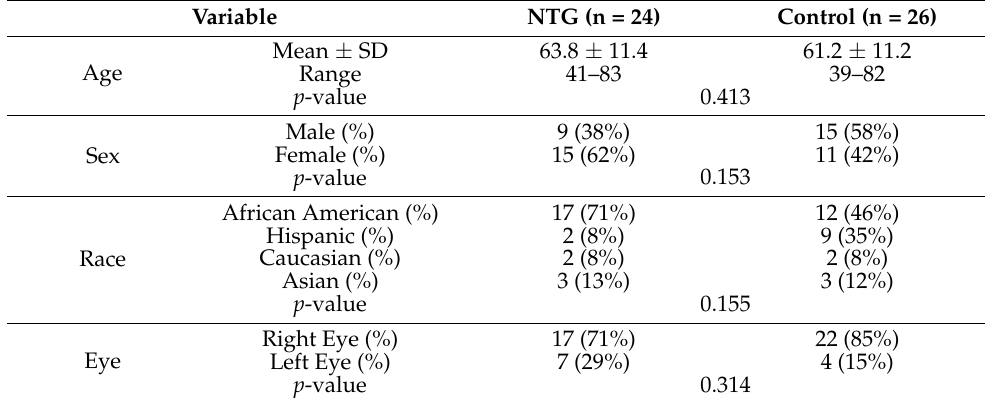
Table 1. Demographic and ophthalmic data of NTG patients and their matched controls.